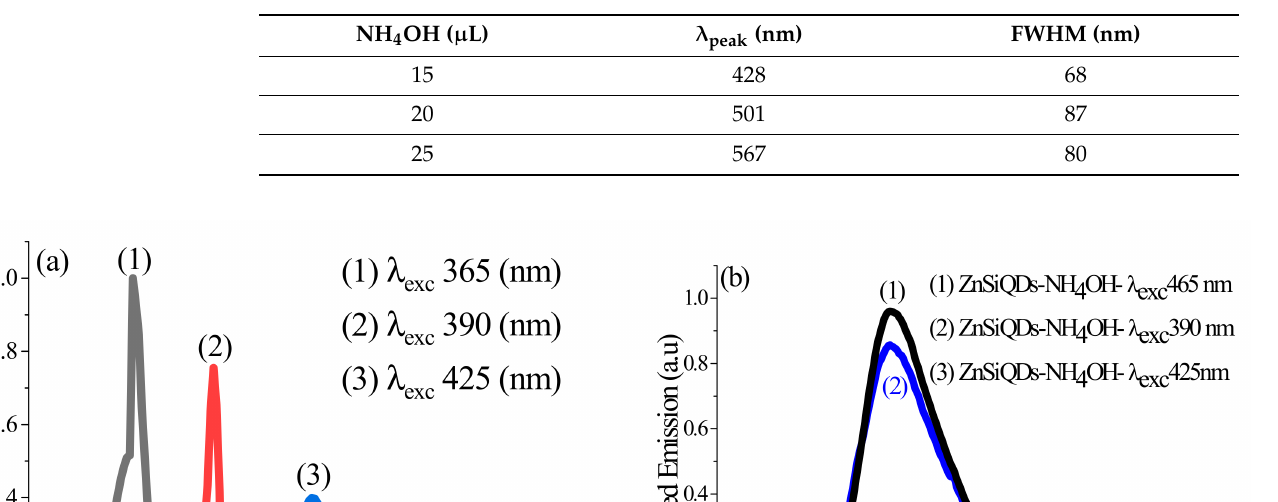
Table 1. Dependence of the emission peak wavelength ( λ peak) and the corresponding spectral full width at half the maximum ZnSiQDs on the variation of the NH 4 OH content.